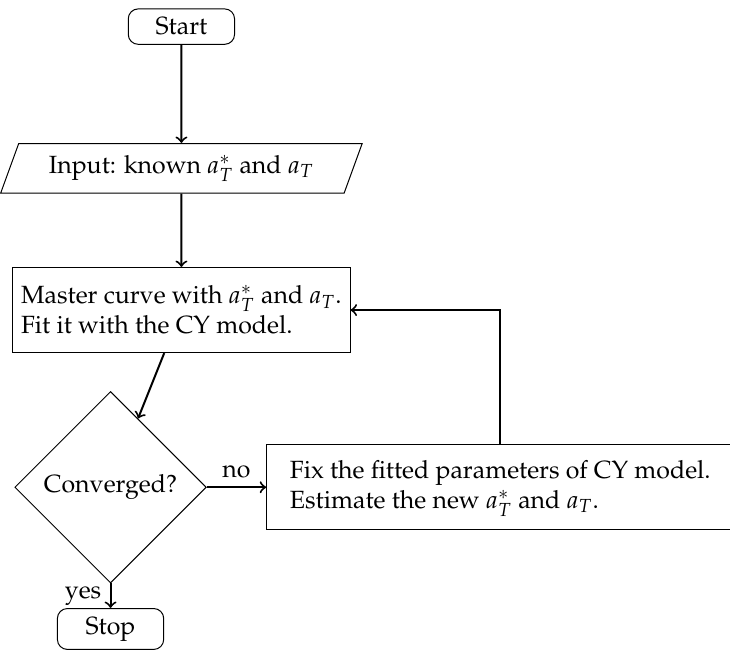
Figure 1. Scenario 1